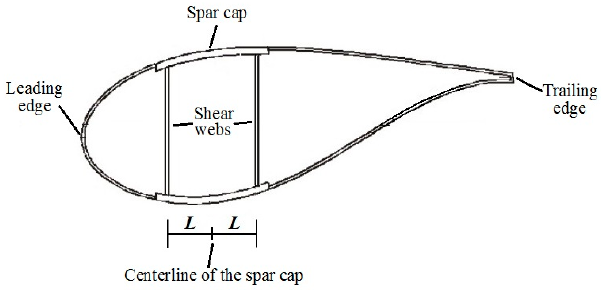
Figure 5. A typical structural form of the blade cross section. Table 1. Material properties of the unidirectional laminates. GFRP: glass fiber reinforced plastic; and CFRP: carbon fiber reinforced plastic.